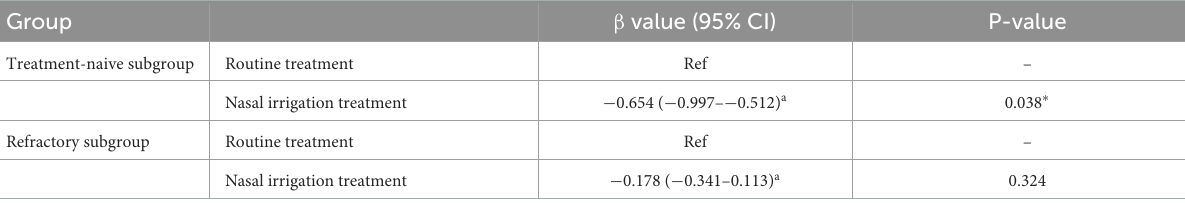
TABLE 6 Multiple linear regression analysis for nucleic acid turning negative time in subgroup. Group